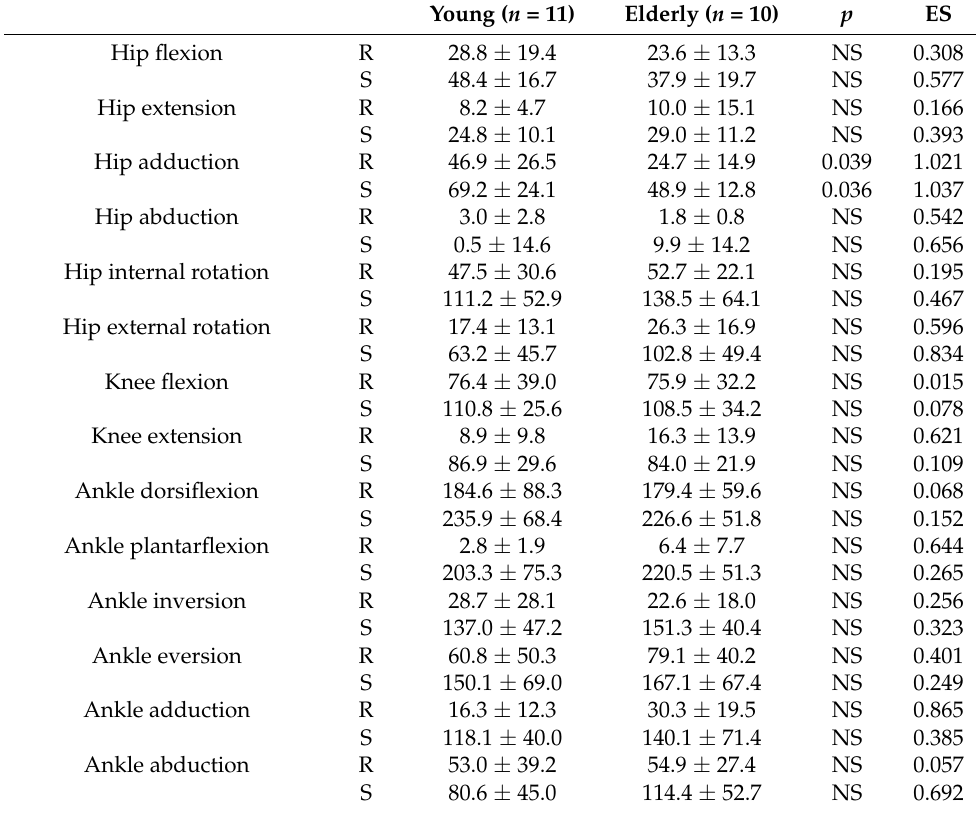
Table 5. Maximum angular velocity of joints during emergency